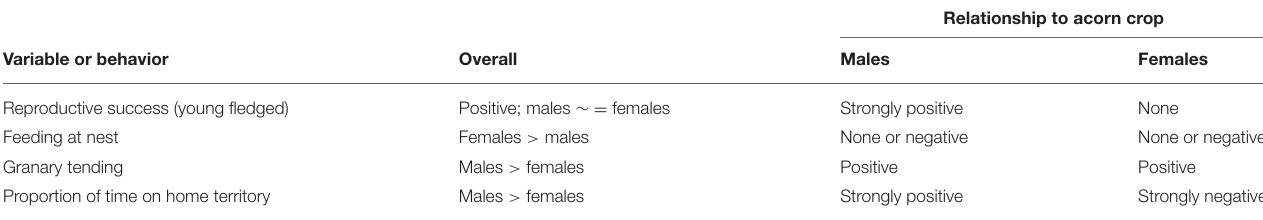
TABLE 6 | Summary of concordance between helper effects on reproductive success and helper behavior.